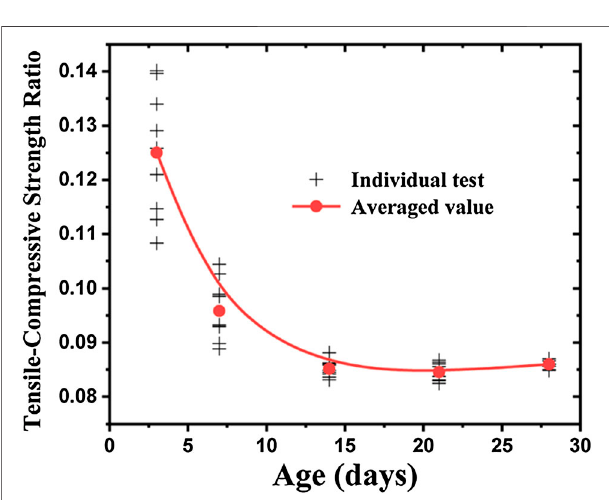
Frontiers in Materials |